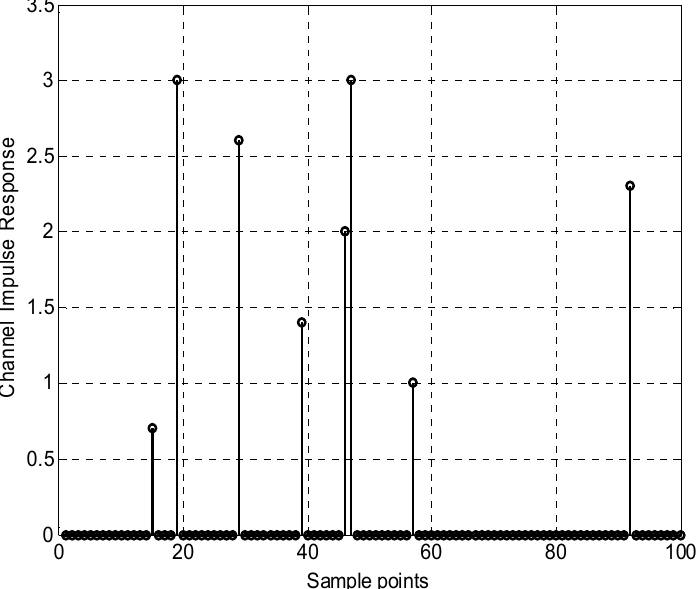
Figure 1. Typical Sample Spaced Sparse Multipath Channel. Reprinted with permission from [38]. Copyright 2018 Elsevier.